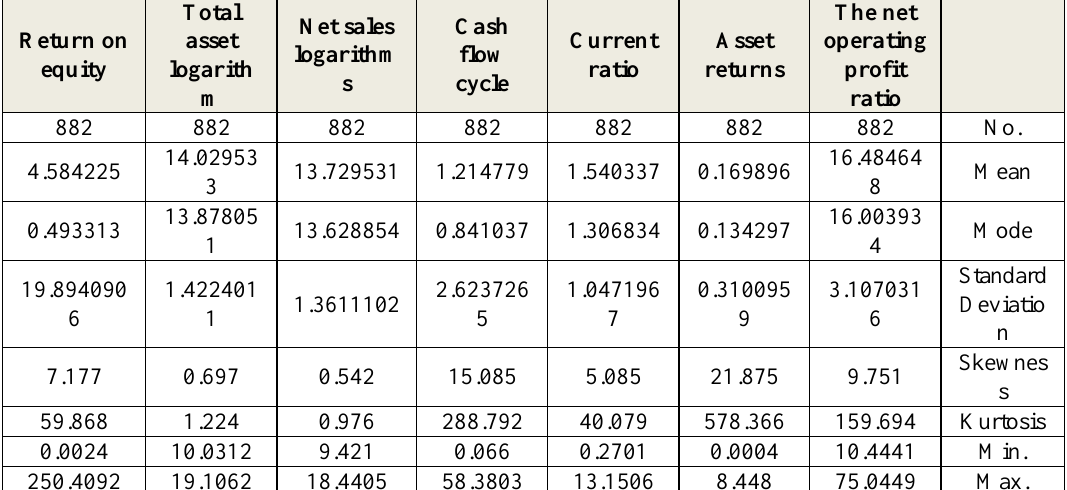
Table 1. Descriptive statistics of research